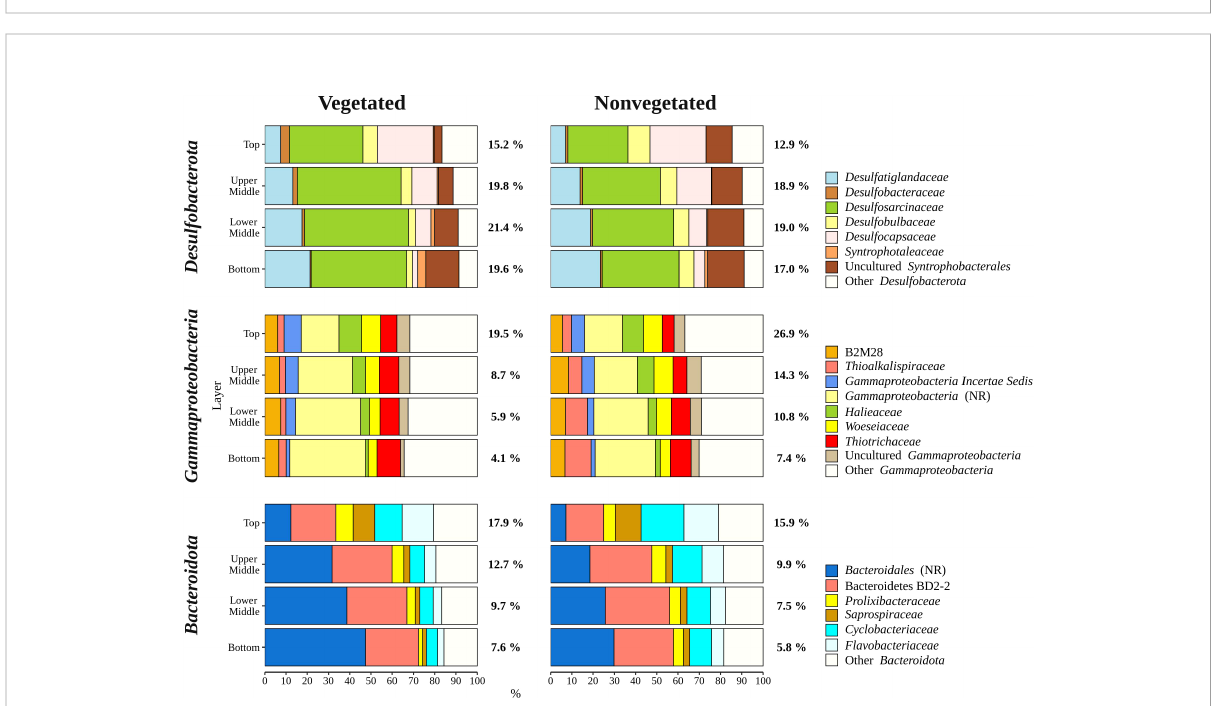
FIGURE 6 Taxonomic classi fi cation and relative contribution of the most abundant ( ≥ 2%) taxonomic groups within Desulfobacterota , Gammaproteobacteria , and Bacteroidota in sediment communities sampled at the vegetated and nonvegetated site in the Bay of Saline. NR – sequences without known relatives.